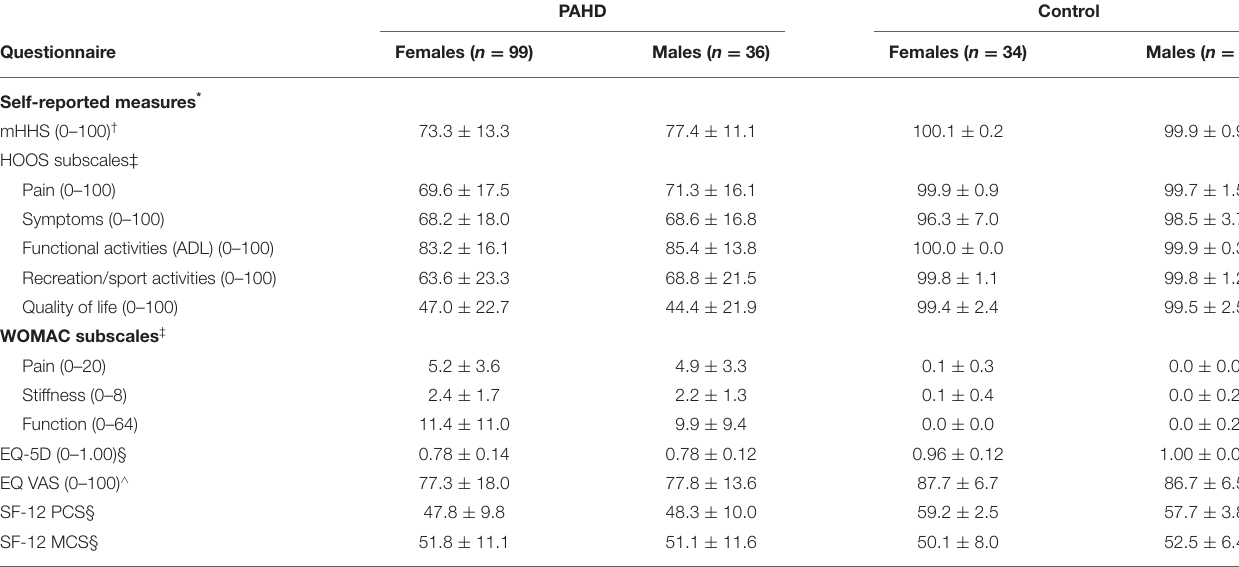
FIGURE 1 | Participant flow diagram. TABLE 2 | Self-reported measures of function and quality of